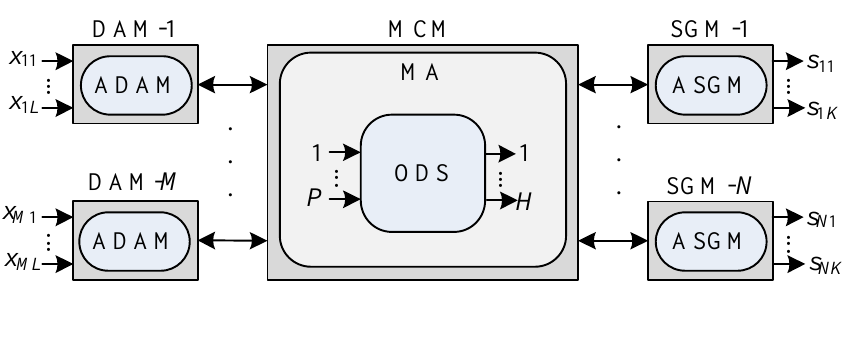
Figure 2. Logical architecture of the RTSDS platform.